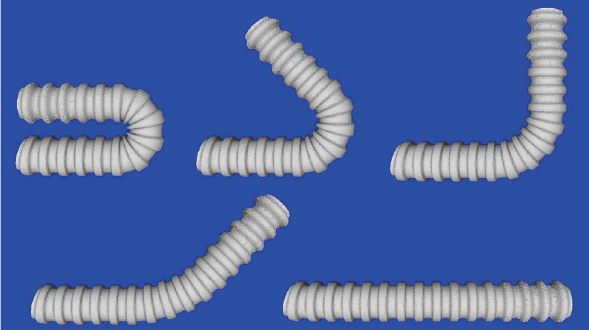
Fig. 1 Centerline-guided generalized cylinder deformation. A generalized cylinder is deformed in large scale while maintaining its local curvature